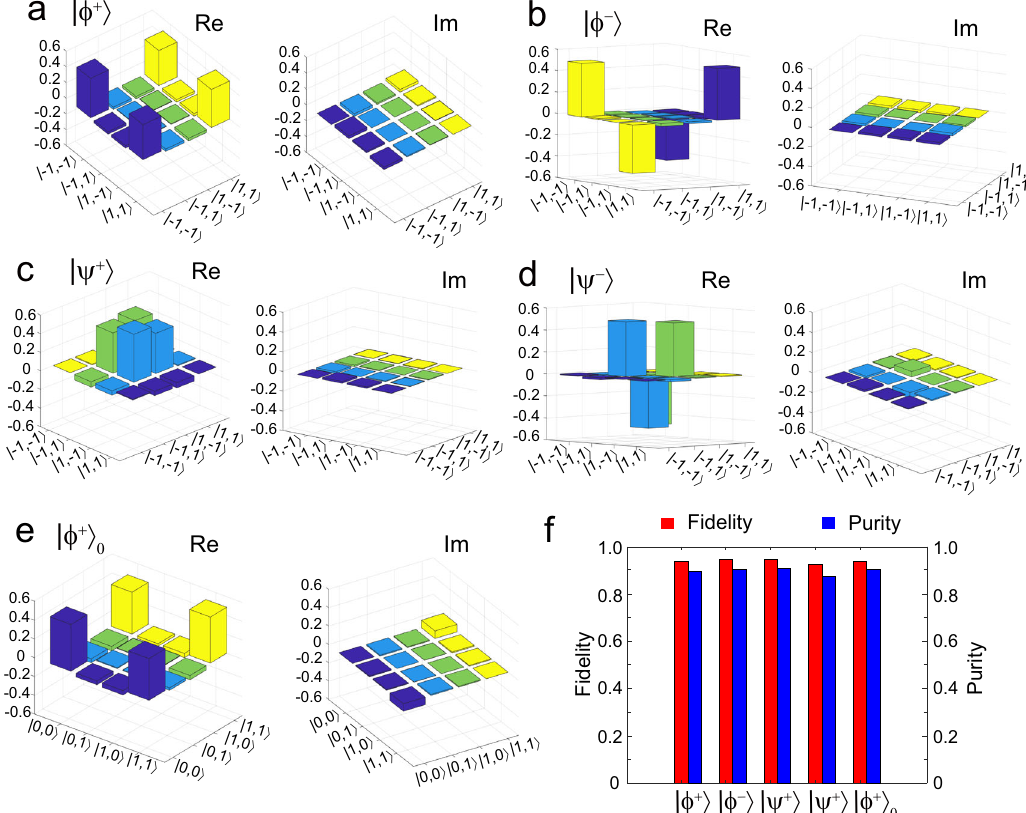
Fig. 4 The measured density matrices, fi delity and purity of the OAM entangled states. a – e The real and imaginary parts of the reconstructed density matrices corresponding to the OAM entangled states ϕ þ